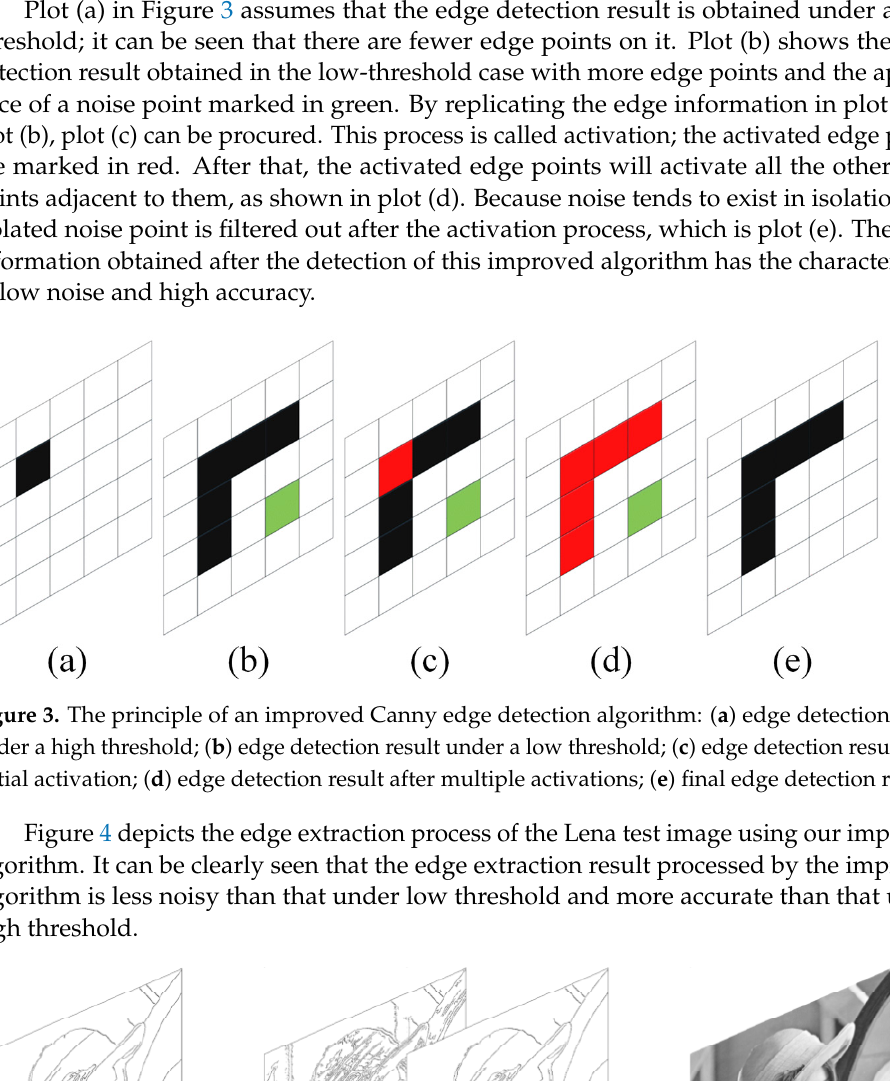
Figure 4. Improved Lena edge detection diagram.